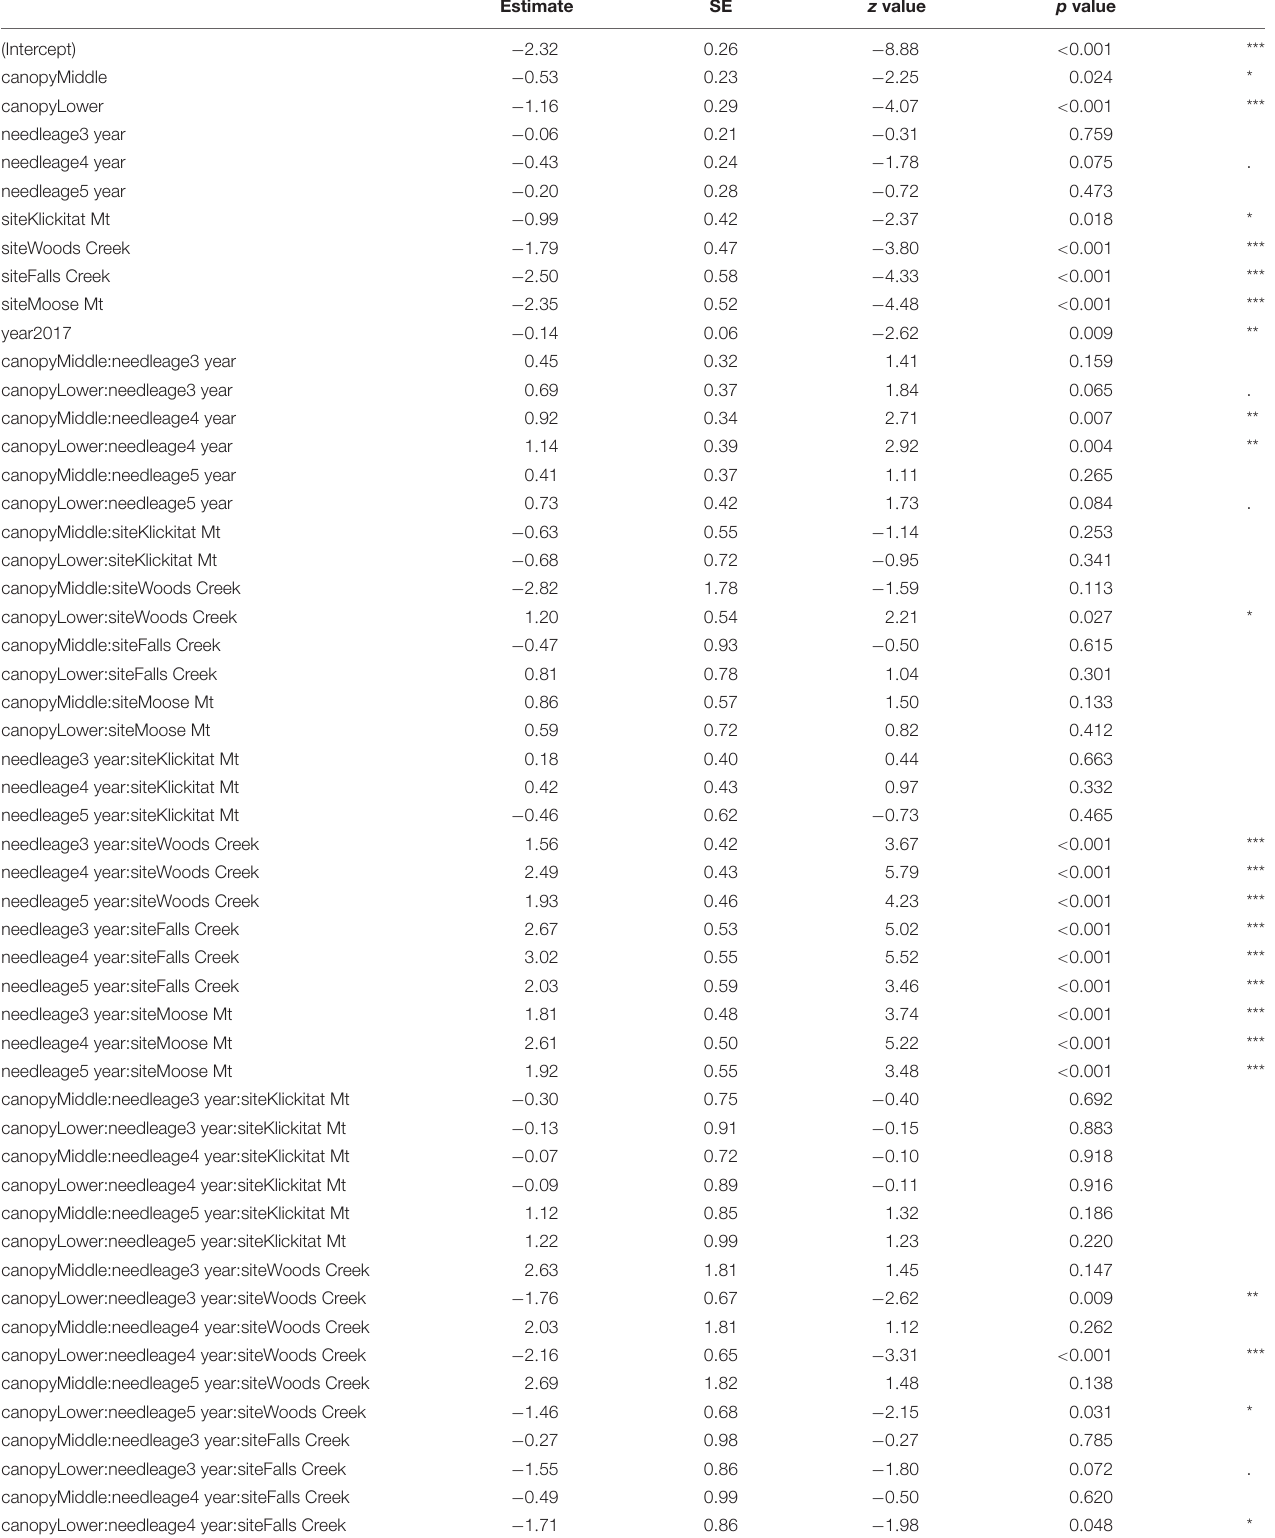
TABLE 3 | Summary of GLMM of pseudothecia density across five study sites (15 trees) in western Oregon, needle age (2–5-year-old), year, canopy position and their interactions.